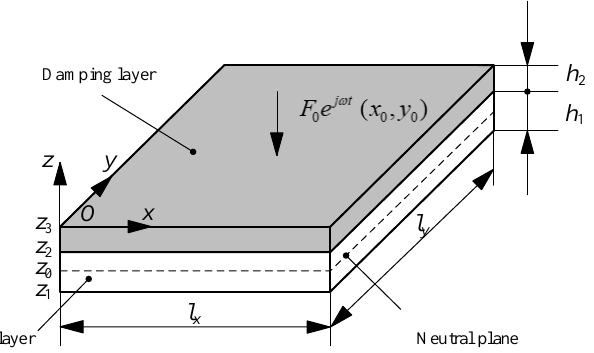
Figure 1. A plate with FFLD treatment under a concentrated harmonic load.